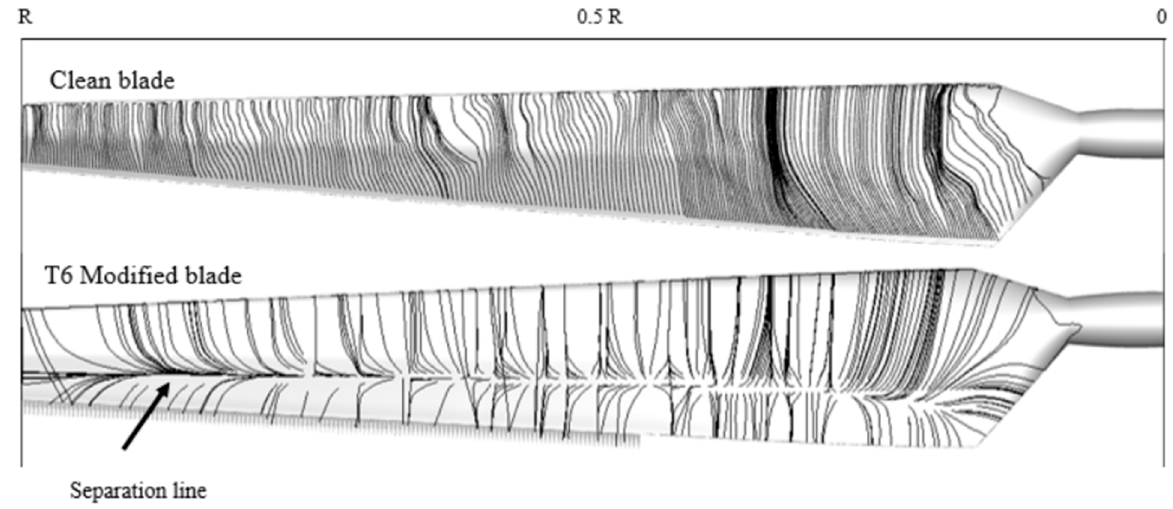
Figure 10. Streamlines over the upper surface of the clean and modified blades for V = 10 m/s .